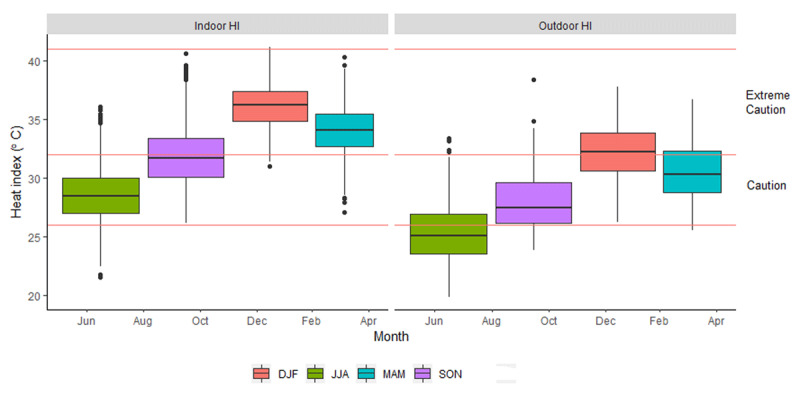
Boxplot of heat index for indoors and outdoors according to the health risk index.